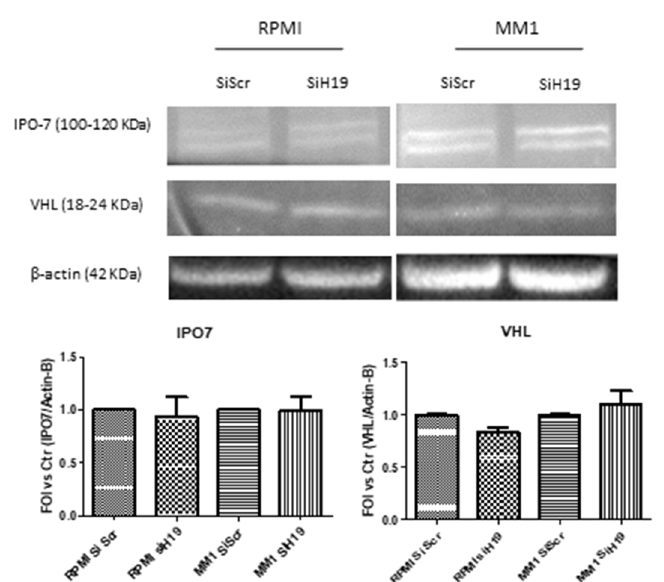
Figure 5. Western blot analysis of IPO7 and VHL on total extract of MM hypoxic cells silenced, or not, for lncH19. Densitometric analysis with Image J software was done with respect to total protein level of β-actin, used as loading control. Values are presented as mean ± SD.